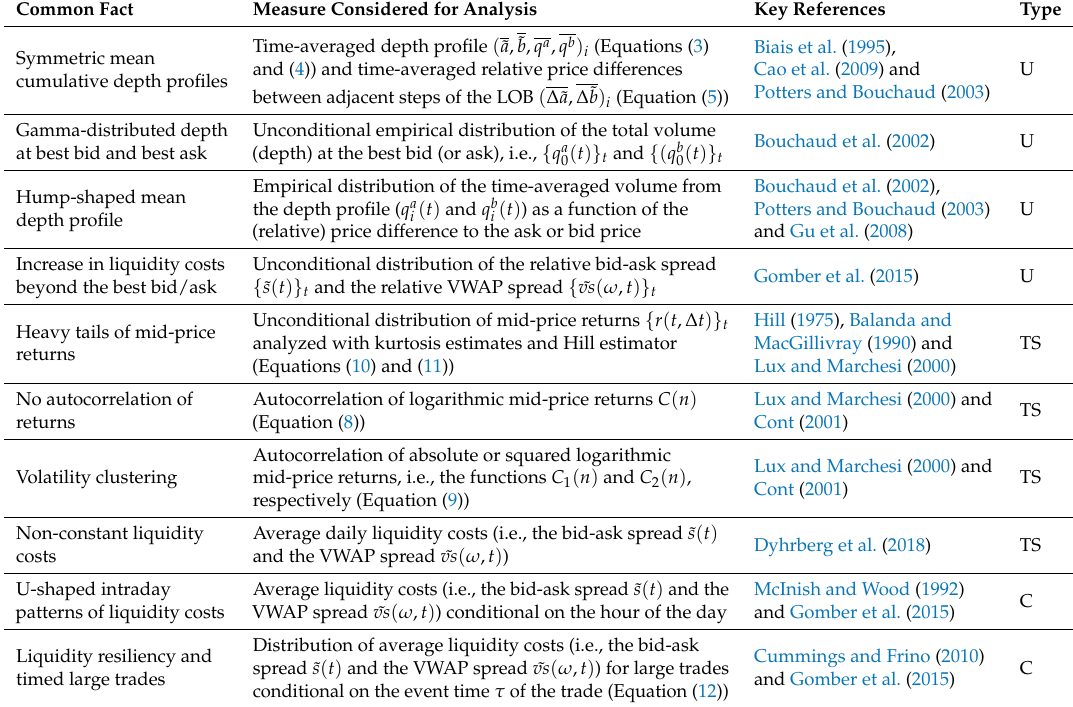
Table 2. Overview of commonly found facts and supporting analyses on static limit order books. Type refers to the class of analysis and is one of U (unconditional statistic), TS (time series statistic) and C (conditional